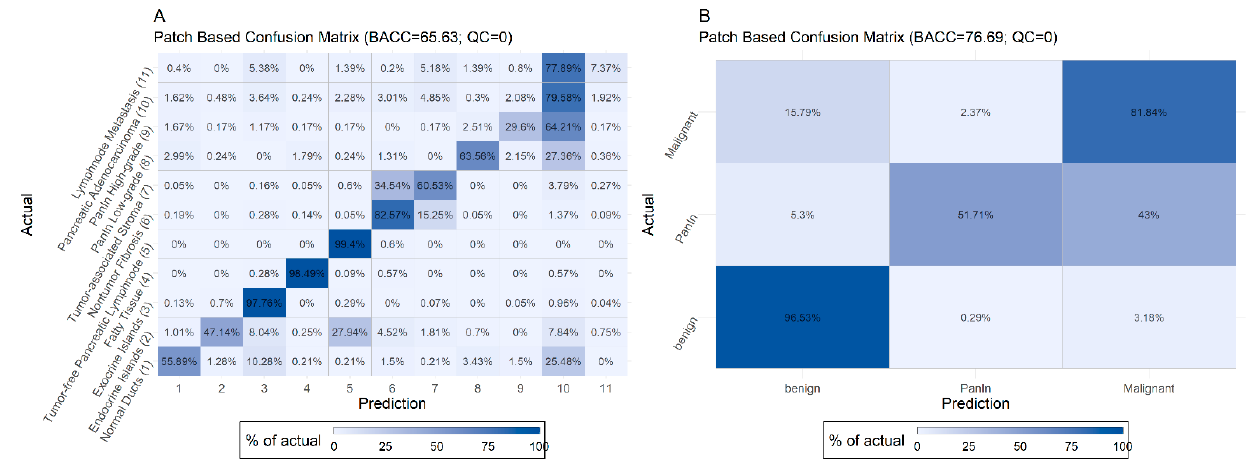
Figure 2. Non ‐ aggregated ( A ) and aggregated ( B ) confusion matrices for all classes for the B2 EfficientNet model and no quality control limit.